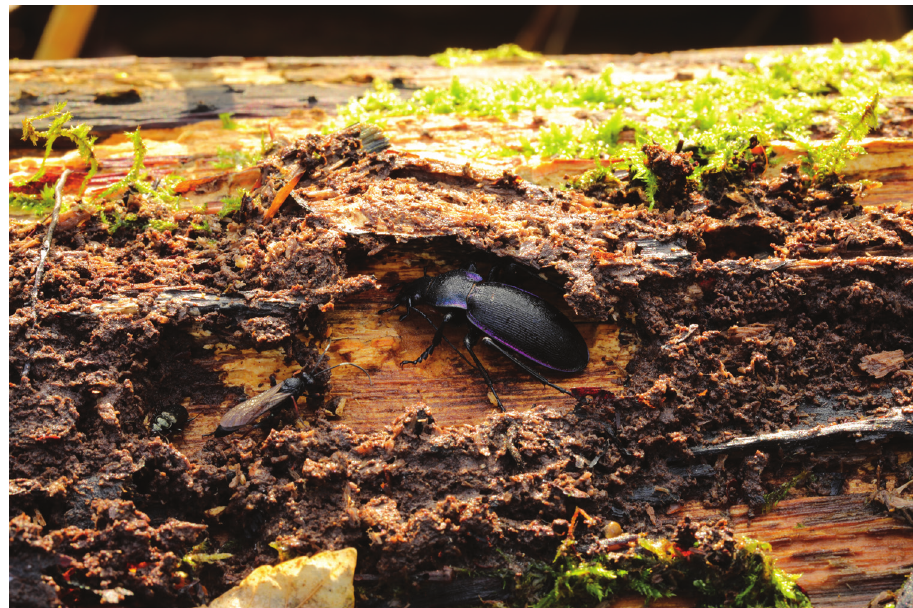
Figure 7. Female Stenichneumon culpator (Schrank, 1802), the most abundant hibernating ichneumo- nid wasp in the Low Countries, often hibernates in spots or galleries made by beetles (left). Here it is in hibernation next to Carabus violaceus Linnaeus, 1758; Belgium, Westouter (Rodeberg), 24 January 2022. Patrick